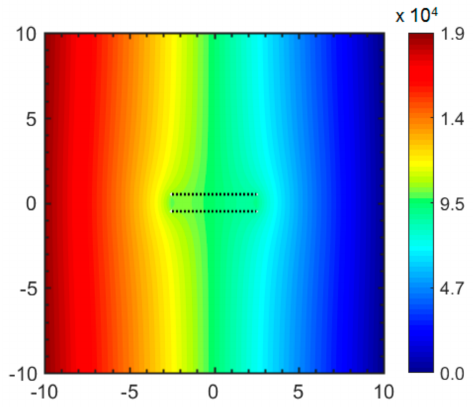
Figure A4. Pressure profile for flow channel superposed with far field flow by separating the real and imaginary terms individually. The branch cut seen in Figure A1 has been removed by the applied procedure. Length scale in feet and pressure (rainbow colors) in